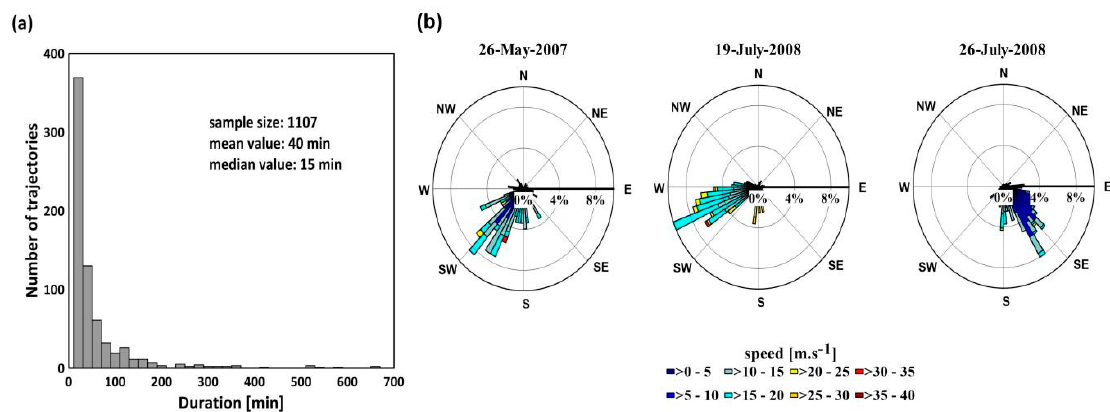
Figure 7. ( a ) Histograms of rain cell duration for identified rain fields, ( b ) wind rose plot of the rain cell motion estimation result, which is sorted by three rainy days.